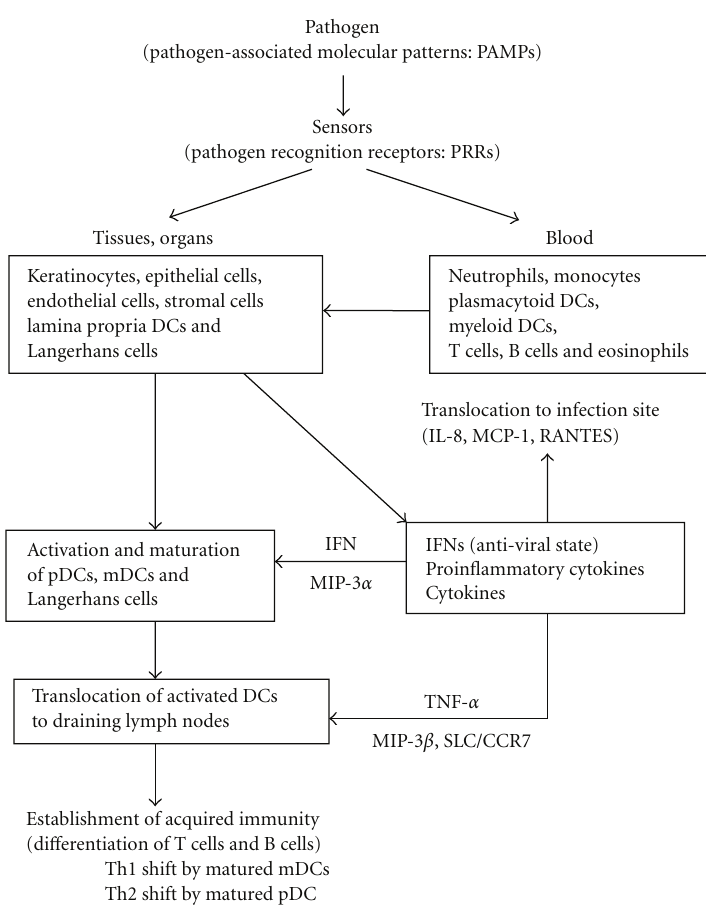
Figure 1: Process of innate immunity to acquired